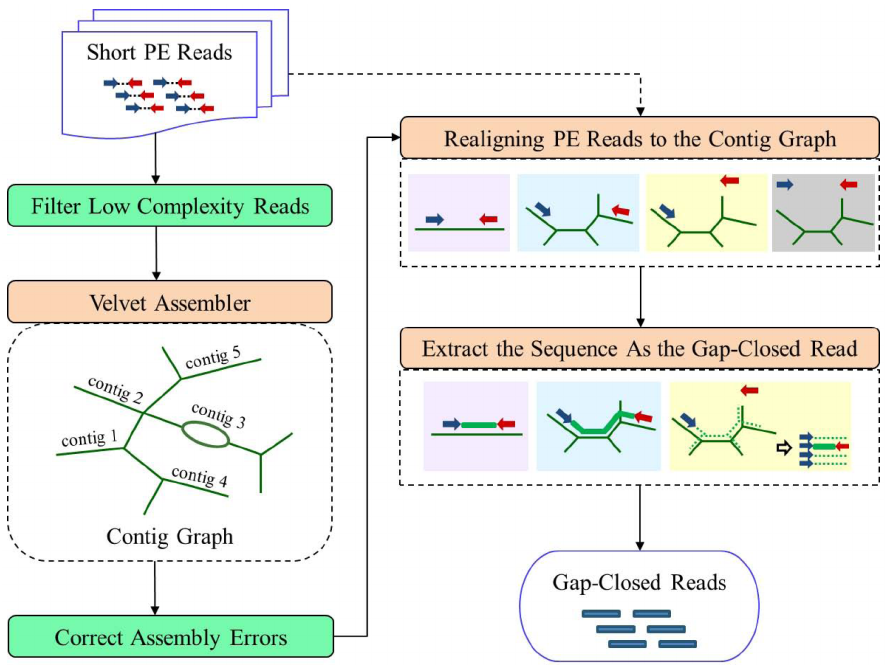
Figure 1. Workflow of ARF-PE. ARF-PE runs in three steps at its kernel (in brown rectangles). First, ARF-PE assembles PE reads into contigs using Velvet and obtains the contig graph. Second, PE reads are re-aligned to the contig sequences. ARF-PE then splits the PEs into four categories based on the mappings of the two reads. Third, ARF-PE extracts the sequences between the two mapped loci as the recovered DNA fragments of PEs. Besides the kernel, ARF-PE offers two options (in green rectangles): filtering low-complexity reads before assembly and correcting errors in contigs after assembly. See main text for details.